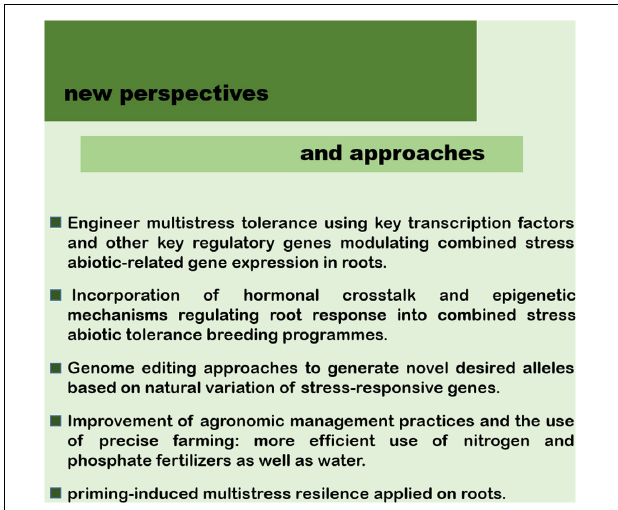
FIGURE 3 | New perspectives and approaches to improve crop root adaptation to multiples stress driven by climate change. Climate change is threatening agricultural productivity. High temperatures together with an increase in atmospheric CO 2 are leading to changes in the rainfall patterns and increase frequency of extreme weather events like drought, freezing and heat waves. The combination of these environmental changes severely reduce crop yield. To be able to cope with the negative effects of climate change and to guarantee food security is crucial to develop crops that are more resilient to these new combined environmental conditions. In this context, robust and better adapted root systems withhold the potential to reach this goal. Moreover, new perspectives and approaches in the implementation of the knowledge of the role of root traits in the adaptation of crops to combined abiotic stresses will be needed to face this